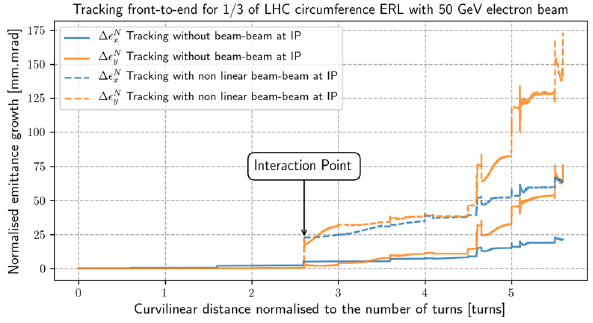
Fig. 22 Emittance growth along the curvilinear coordinate for the largest ERL design, corresponding to 1/3 of the LHC circumference